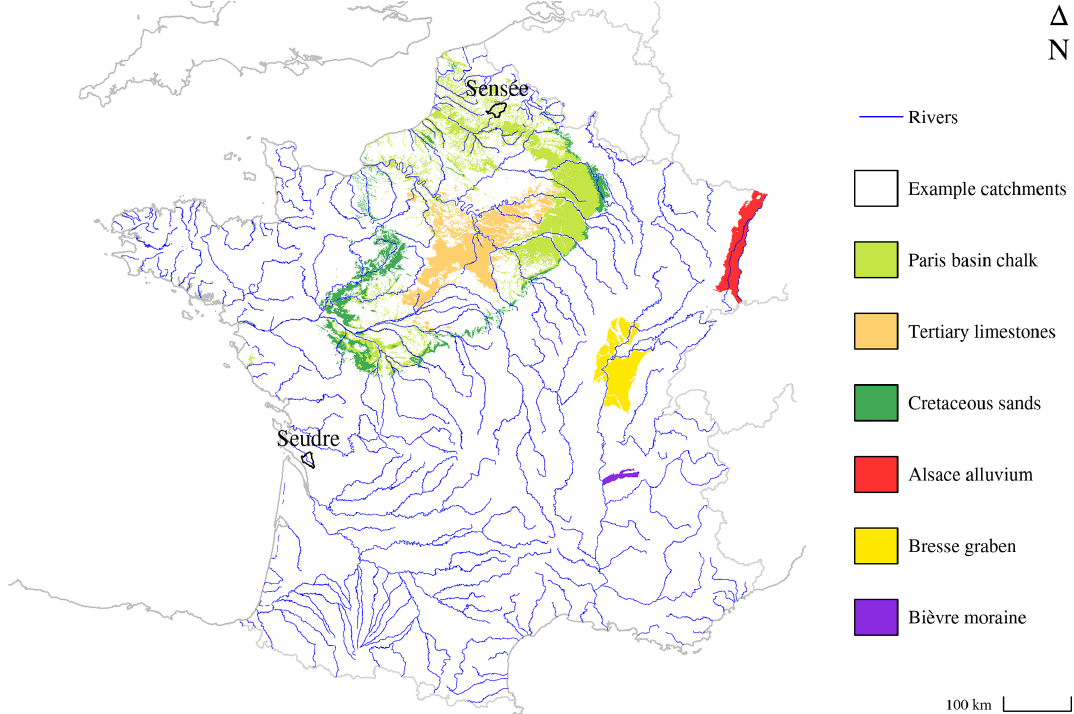
Figure 1. Outcropping areas of several major aquifers in mainland France, and the locations of the example catchments shown in Fig. 2.